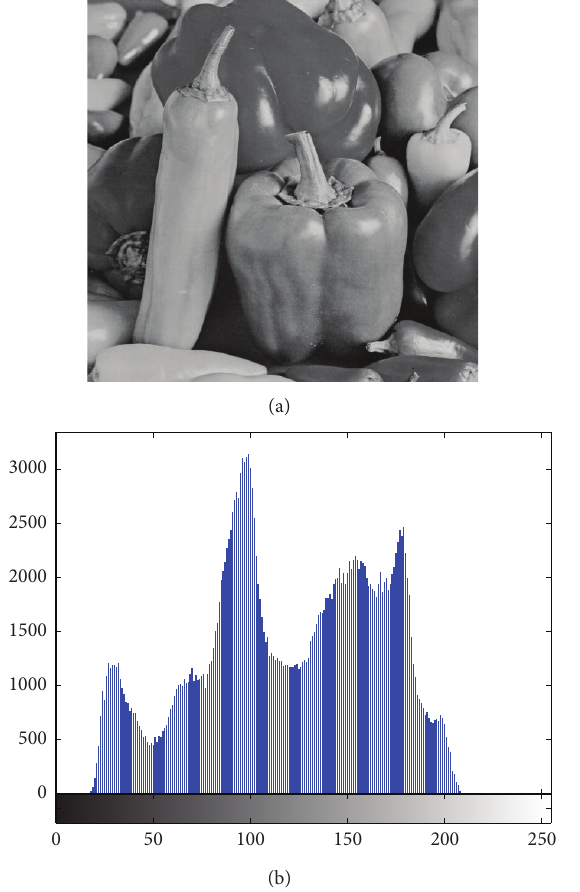
Figure 9: (a) Decrypted image and (b) its histogram.